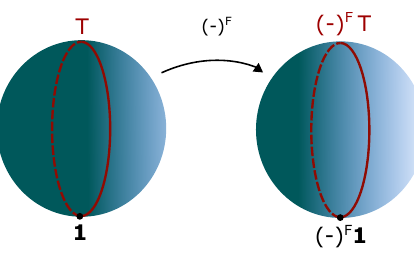
Figure 12 . Schematic of the topology of the compact supergroup discussed here, with two con- nected components related by acting with ( − ) F . The full maximal torus = (cid:8) T, ( − ) F T (cid:9)